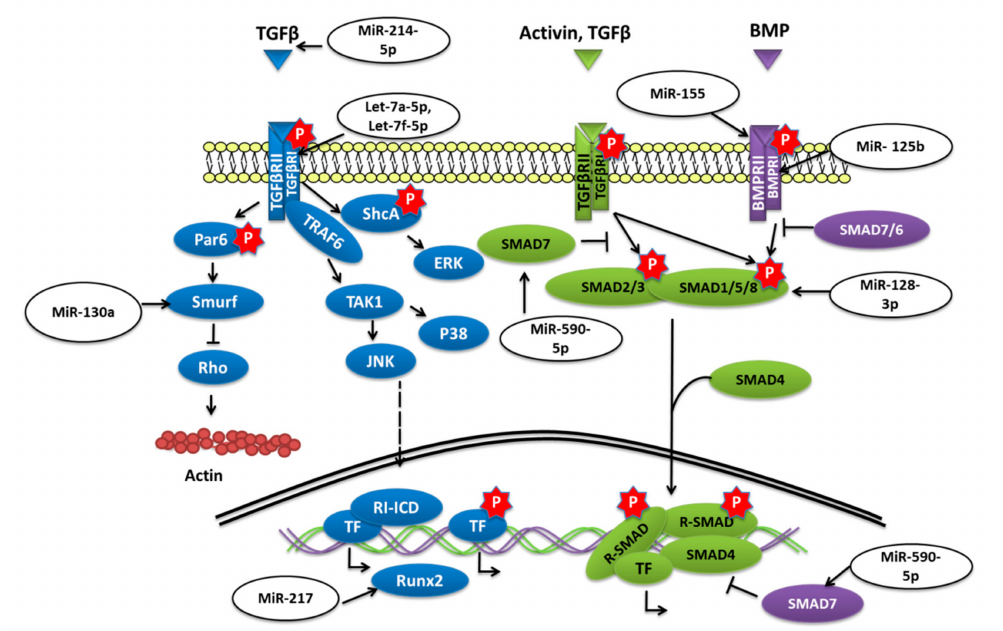
Figure 3. miRNAs targeting di ff erent components of TGF- β / SMAD